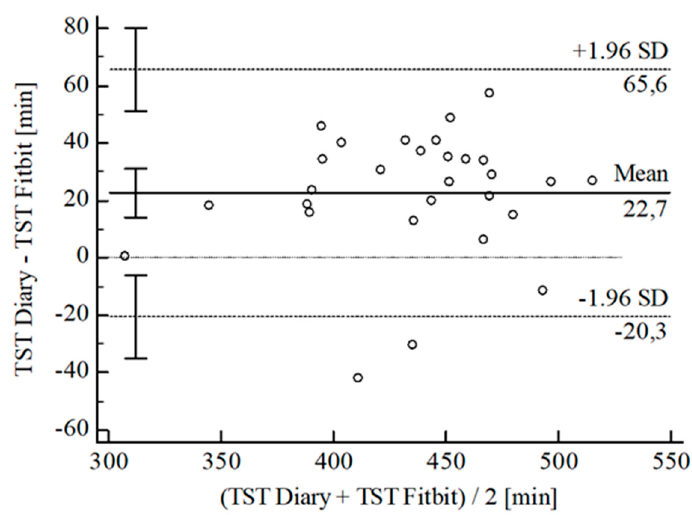
Figure 5. Bland-Altman plot for TIB Polar ® vs. diary.